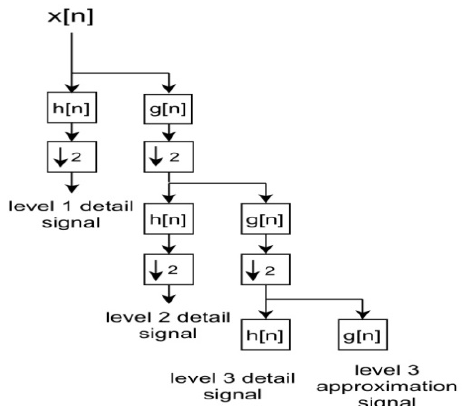
Figure 3: Discrete wavelet